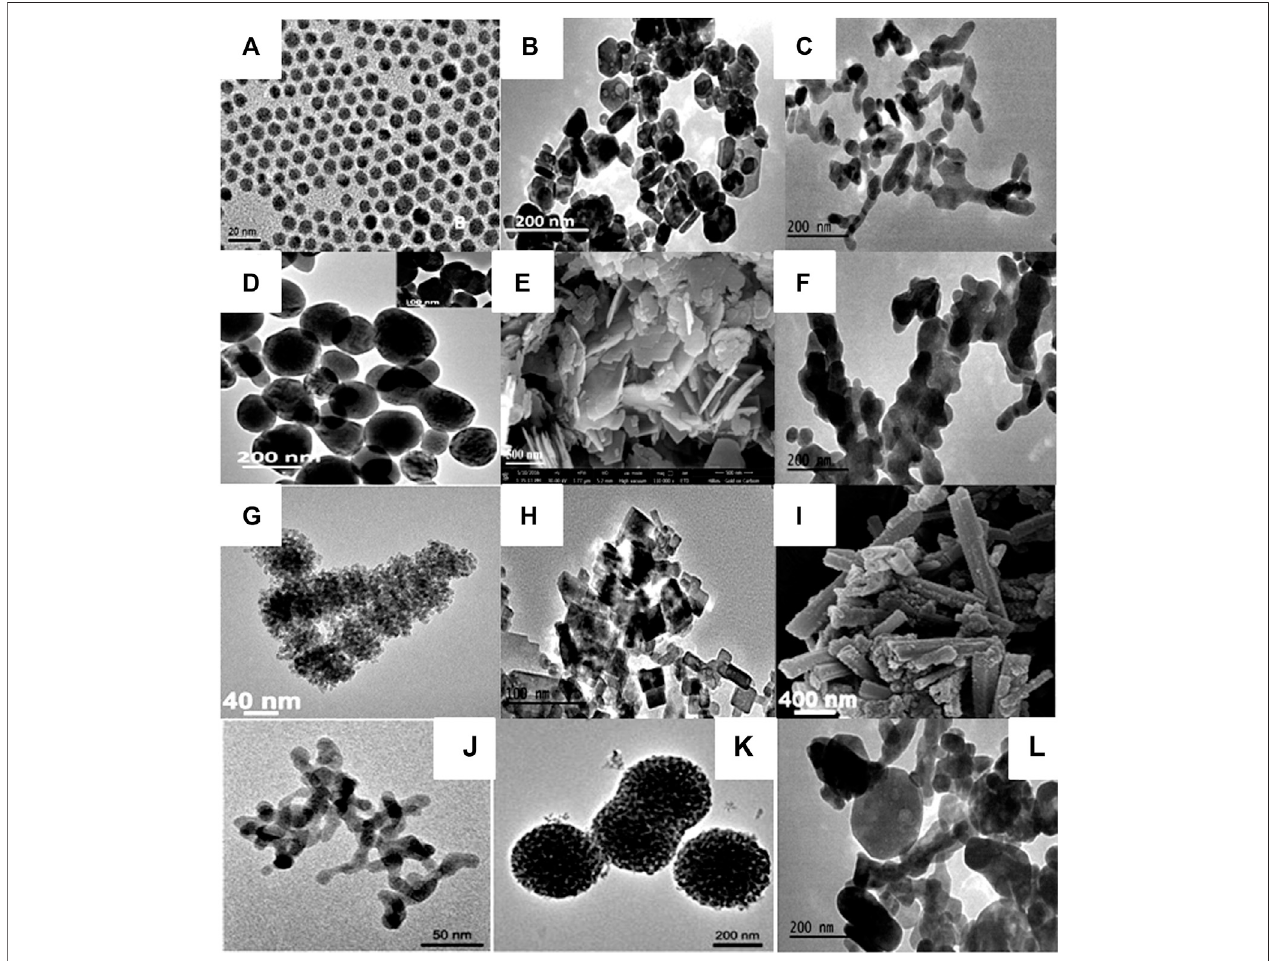
FIGURE7| (A) TEMimagesNaYbF 4 ,2%Tmnanocrystals(Panetal.,2013), (B) TEMimagesoftheCeF 3 :Tb 3+ (Ghoshetal.,2017), (C) TEMimageofNaSmF 4 (Ghosh et al., 2017), (D) TEM image of the NaYbF 4 :Er 3+ nanoparticles (Ghosh et al., 2017), (E) SEM image of the BaF 2 :Ce 3+ (0.1%) synthesized using [C 4 mim][BF 4 ] (Sharma et al., 2020a), (F) TEMimageofNaTbF 4 :Ce 3+ (Ghoshetal.,2017), (G) TEMmicrographsofLaF 3 :1%Dy 3+ ,5%Tm 3+ (LorbeerandMudring,2013a), (H) TEMimageofBaF 2 :Ce 3+ / Tb 3+